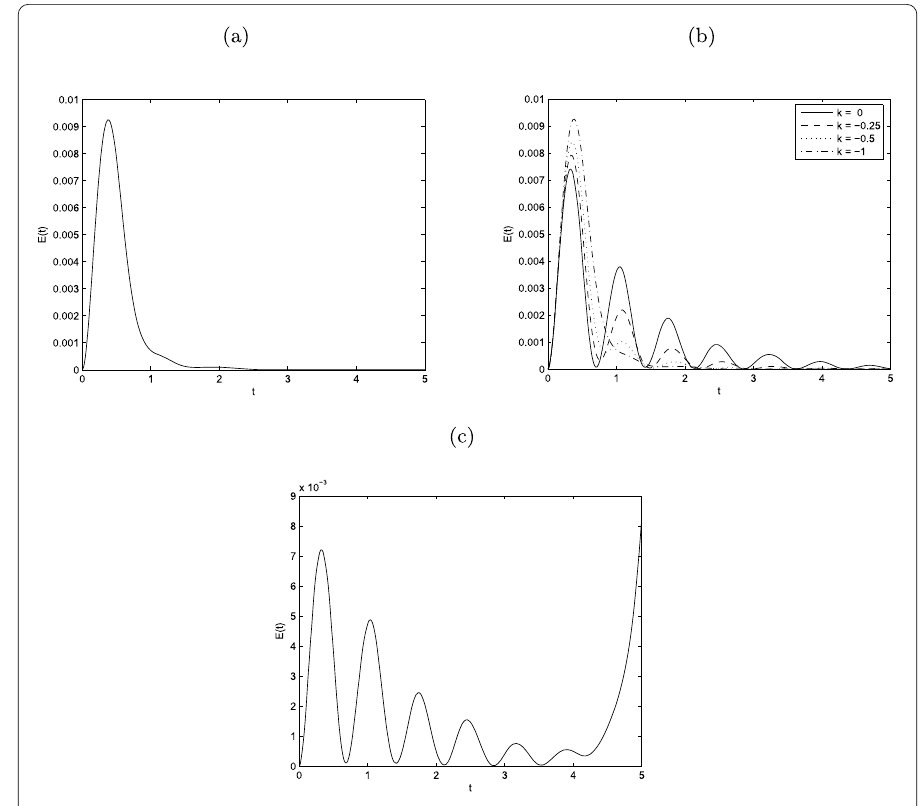
Figure 3 The energy E 0 ( t ) of the wave system without delay (3.13)–(3.16) when: a) a ( x ) = 1, and k = –1; b) a ( x ) = 1, and for negative values of k ; c) a ( x ) = 1, and k = 0.1